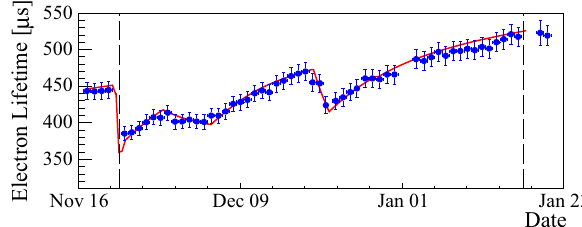
Fig. 19 Evolution of the electron lifetime over science run 0, which is indicated by the vertical lines. The two step-like decreases are well- understood and related to detector operation (e.g., online 222 Rn distil- lation which started on December 19). The model (red line) describes the data